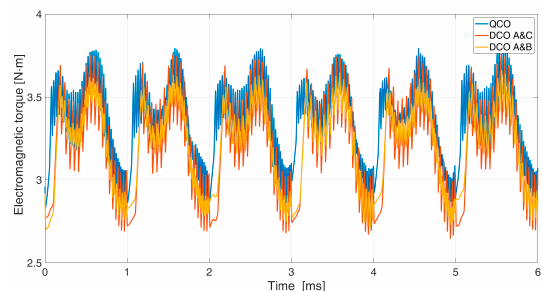
Figure 11. Waveforms of electromagnetic torque—variant I.